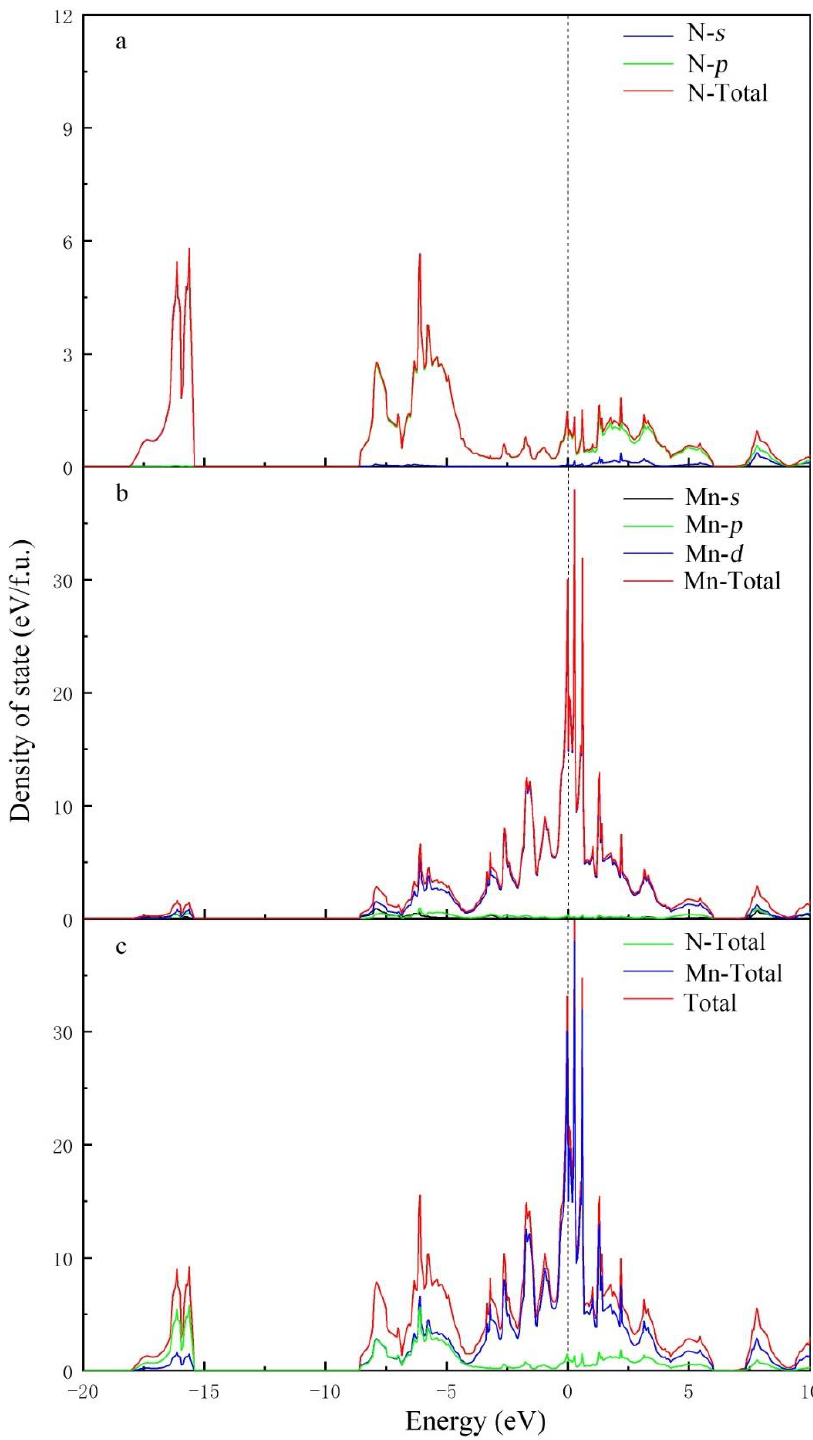
Figure 5. Total and partial density of states for Mn 3 N 2 . ( a ) The s and p orbitals, and TDOS of N atoms. ( b ) The s , p , and d orbitals, and TDOS of Mn atoms. ( c ) The TDOS of Mn atoms, the total TDOS, and the TDOS of N atoms.